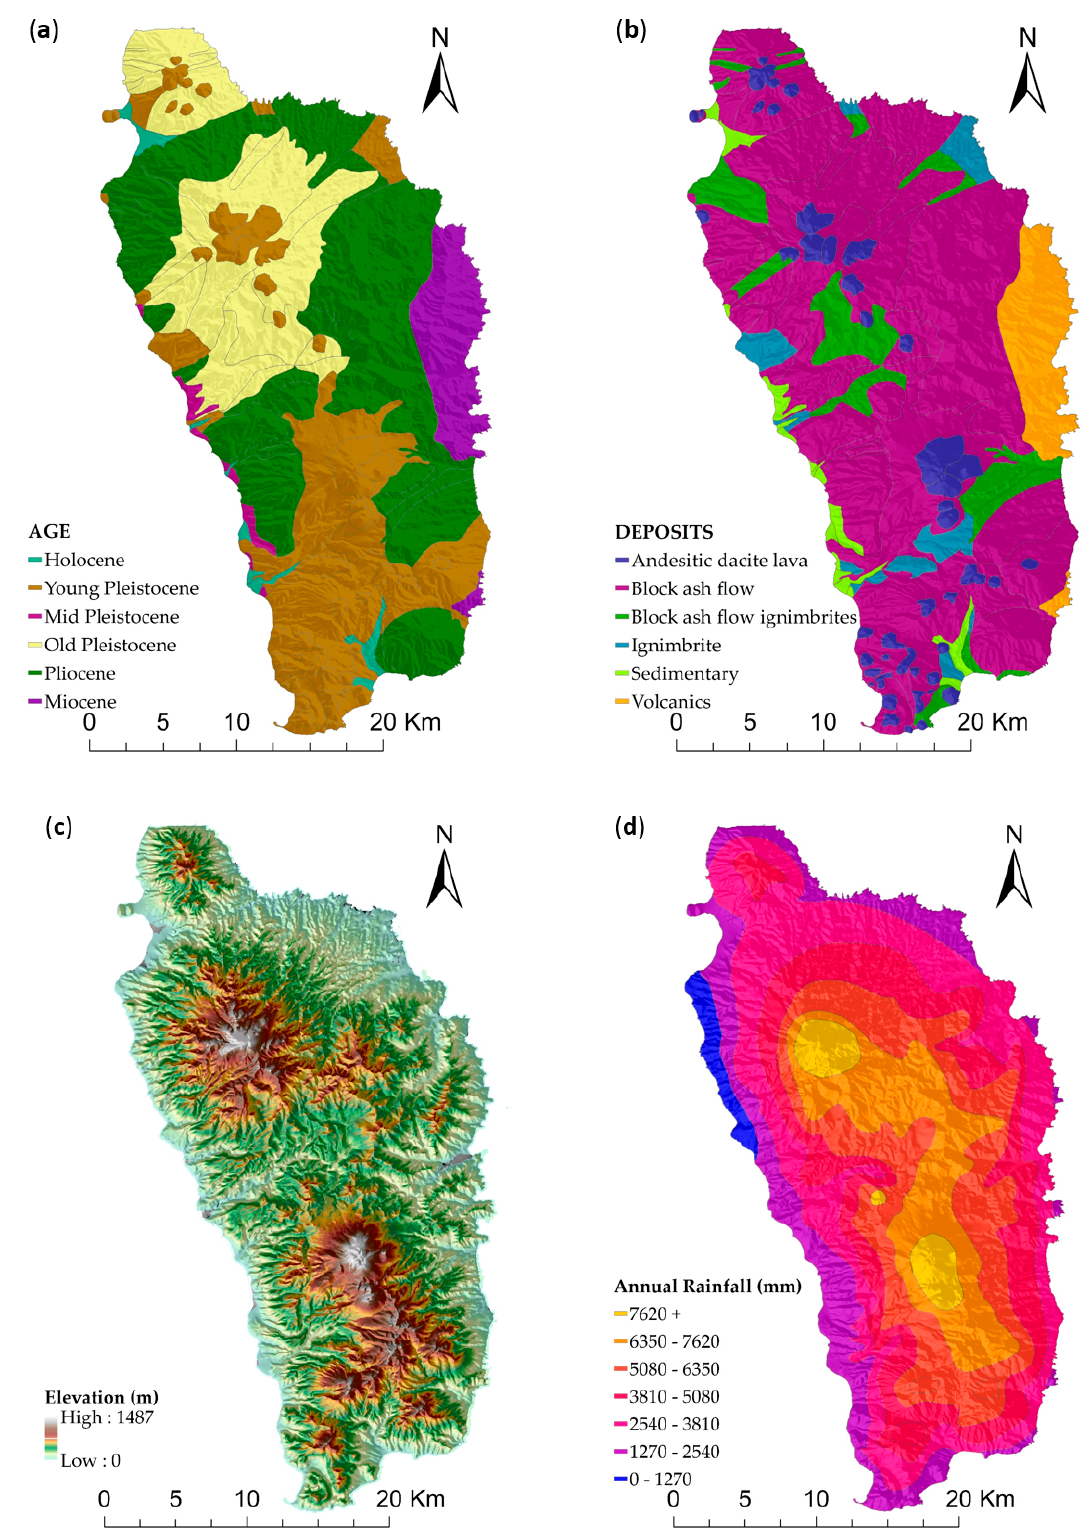
Figure 2. ( a ) Geological age, ( b ) deposits, ( c ) elevation, and ( d ) annual rainfall amounts of Dominica overlaying a Digital Elevation Model (DEM) derived shaded relief. ( a – c ) were produced from data provided from [42], while ( d ) was developed from data provided from [43].